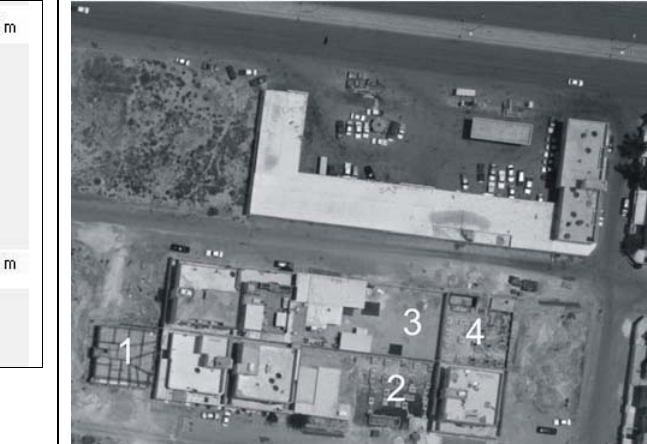
Figure 25: changes of buildings in positions marked by 1 –